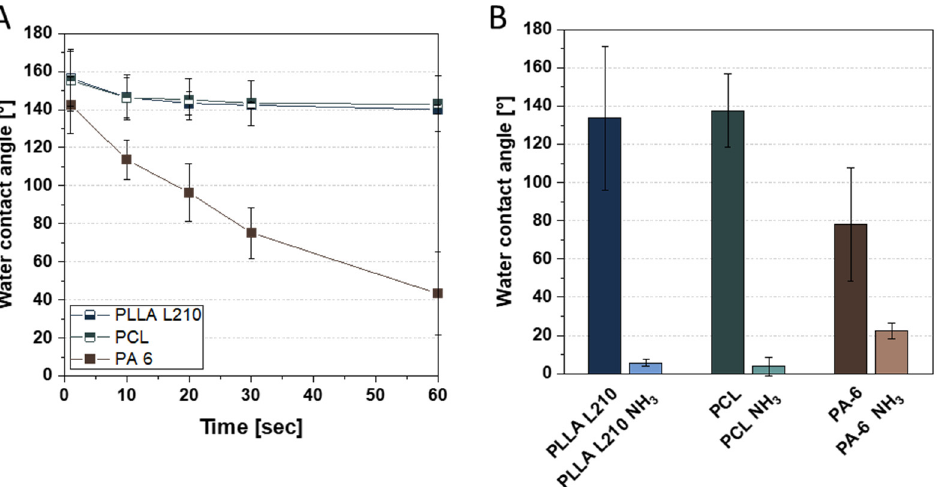
Figure 5. Water contact angle of ( A ) time-resolved measurement over 60 s using untreated nonwoven material and ( B ) measurement after a few seconds using untreated and NH 3 -plasma functionalized PLLA L210, PCL and PA-6 nonwovens.